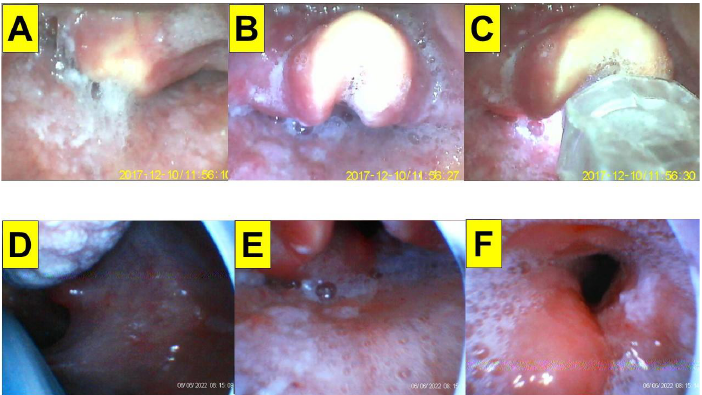
Figure 4. Application of video-twins technique in a patient underwent an elective surgery. A 54- year-old man with a BMI 19.2 kg/m 2 . Mallampati class III and Cormack-Lehane laryngoscopic view grade 3: ( A – C ) videolaryngoscopic views; and ( D – F ) views from intubating stylet. Intubation time was 8 s. (also see the Supplementary Materials — Videos S4 and S5). Intubating devices: UE and Trachway.